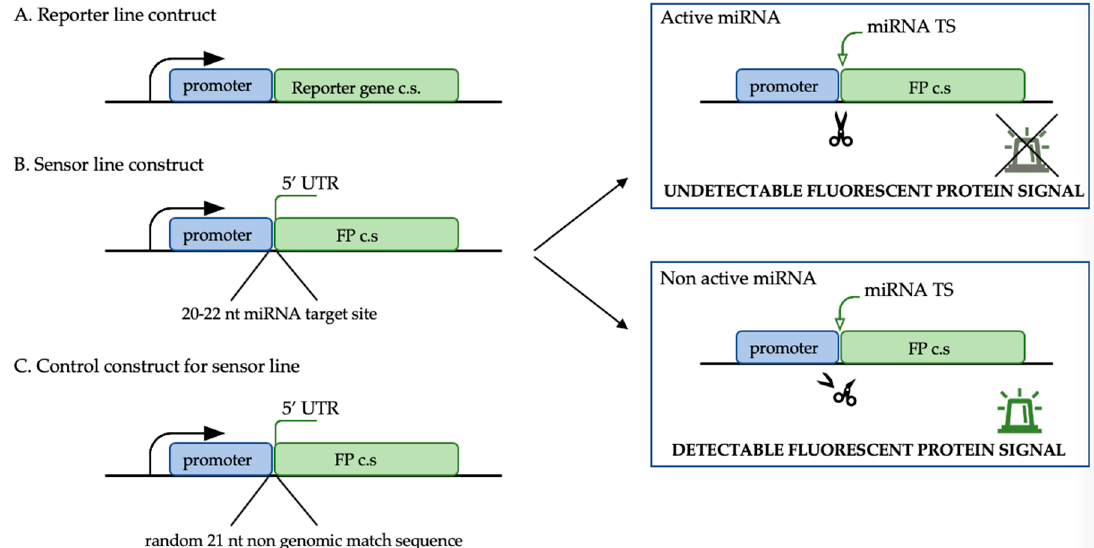
Figure 3. The constructs that were used for the spatio-temporal analysis of the miRNAs; ( A ) the reporter line construct with the promoter of choice (usually a promoter of the MIRNA gene); ( B ) the miRNA sensor line construct that was used for the analysis of miRNA activity with the miRNA target site and the control construct ( C ) for the sensor line analysis. FP: Fluorescent protein; c.s.: Coding sequence.